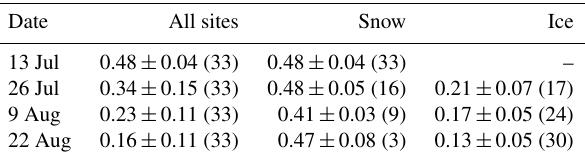
Table 4. Mean albedo values ( ± 1 σ ) along the Haig centreline tran- sect during four surveys in summer 2017: glacier average and for the subset of sites over seasonal snow and glacier ice. The number in brackets indicates the number of samples for each average. Snow values at three of the sites on the upper glacier are estimated on 9